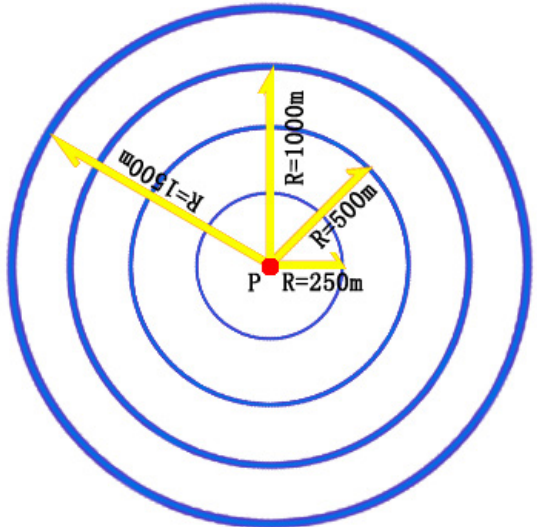
Figure 3. Extent sizes of each